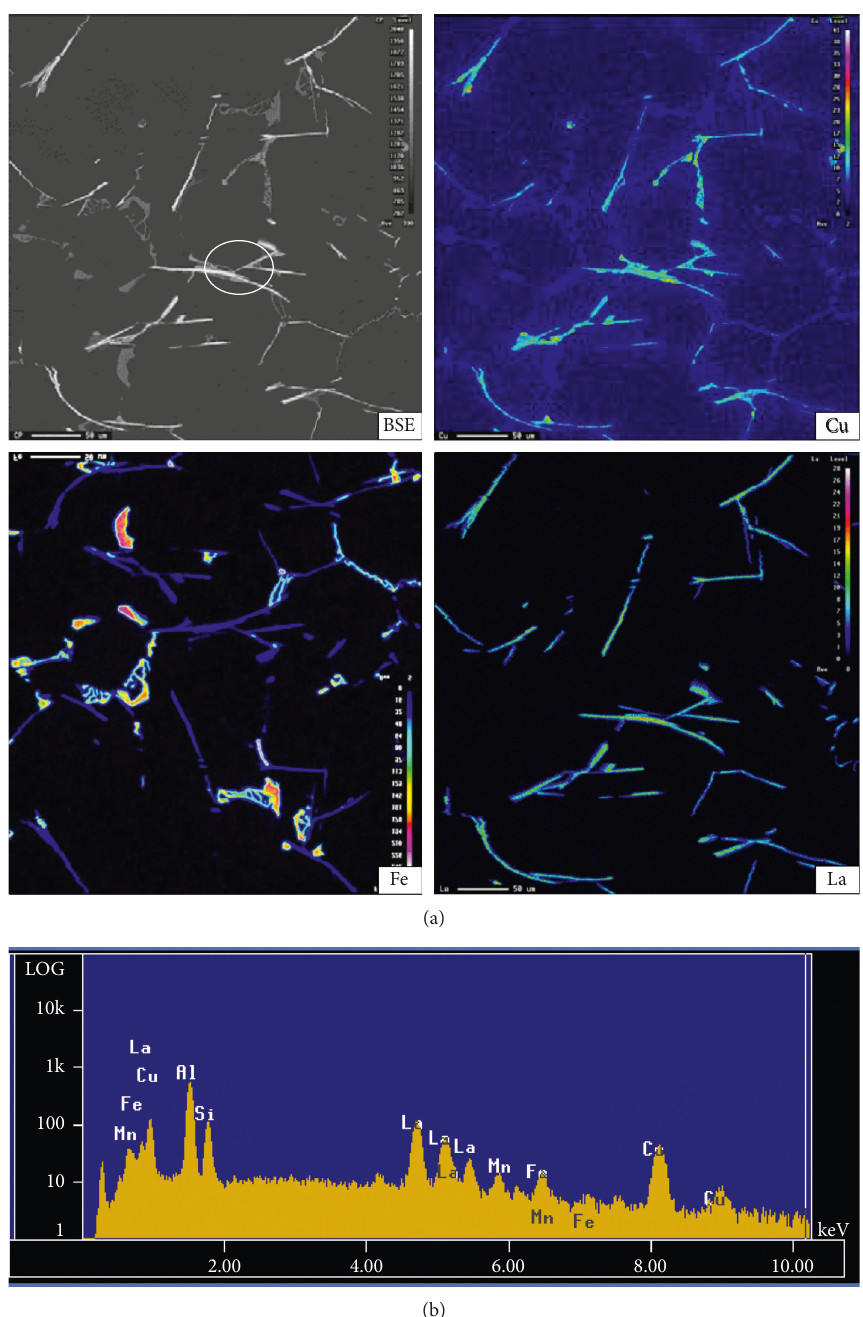
Figure 13: La-transition metal interactions in D0+La alloy: (a) backscattered electron image and corresponding Cu, Fe, and La images and (b) EDS spectrum of white phase circled in